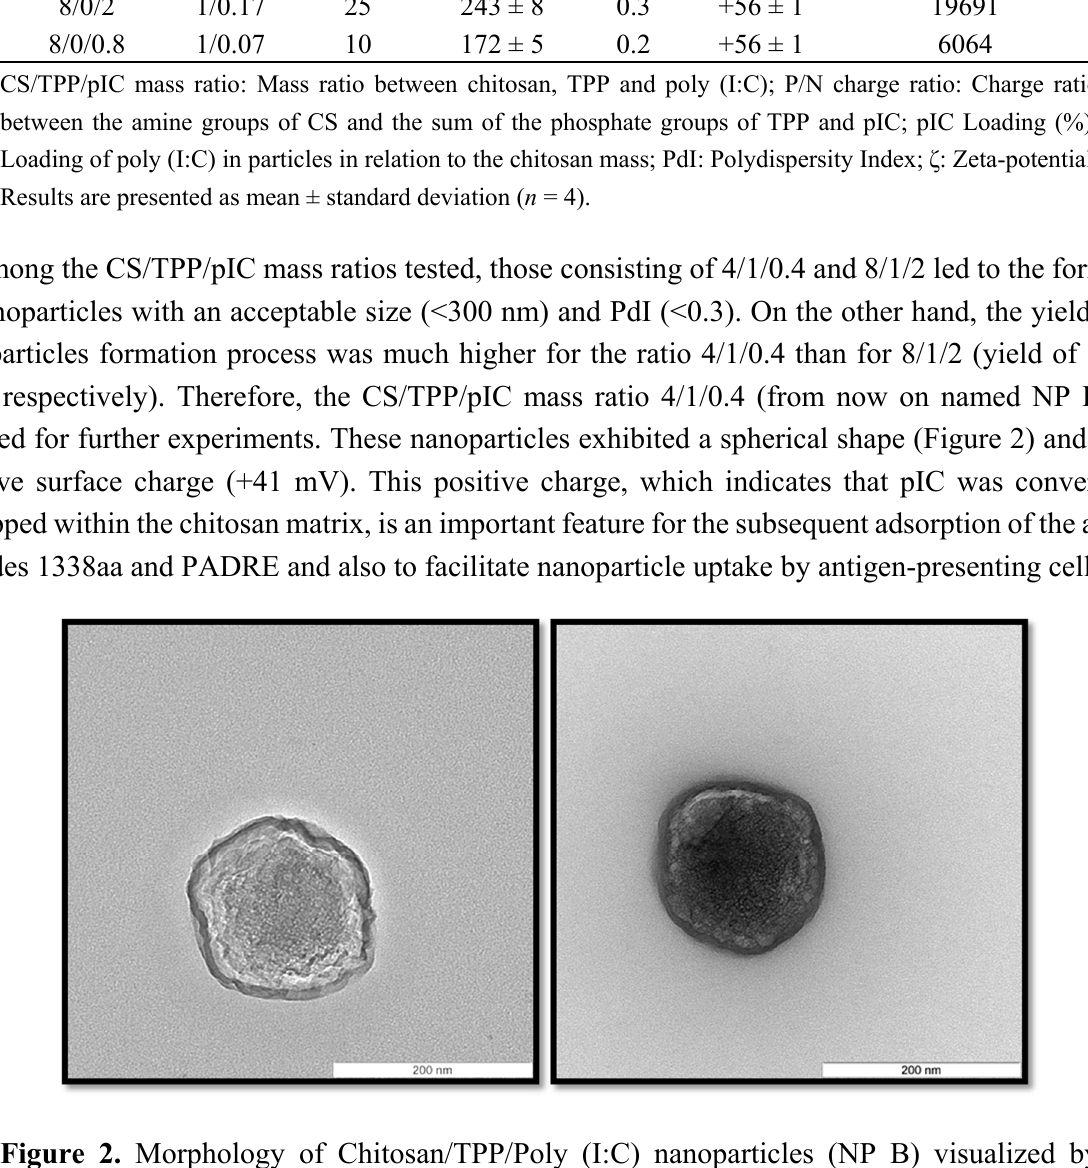
Figure 2. Morphology of Chitosan/TPP/Poly (I:C) nanoparticles (NP B) visualized by transmission electron microscopy. The scale bars correspond to 200